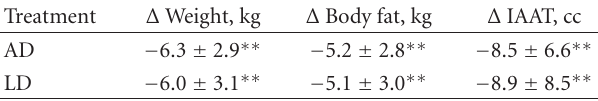
Table 3: Change in weight, body fat, and intra-abdominal adipose tissue in adult women and men consuming low-dairy (LD) or adeq- uate dairy (AD) diets after a 12-week caloric restriction interven- tion.